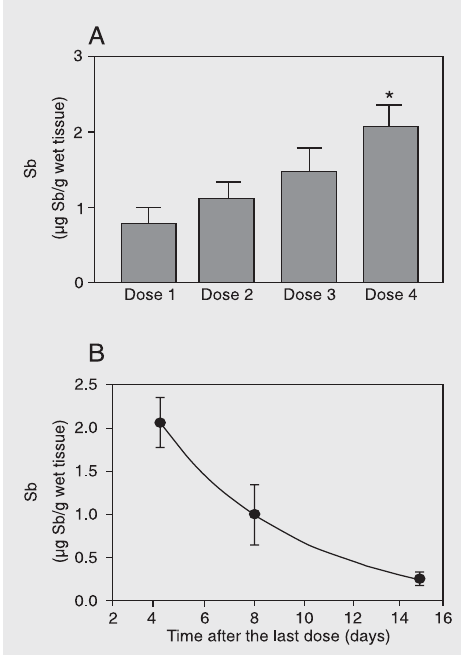
Figure 1. Bone marrow antimony levels determined in infected dogs, during (A) and after (B) treatment with liposome-encap- sulated meglumine